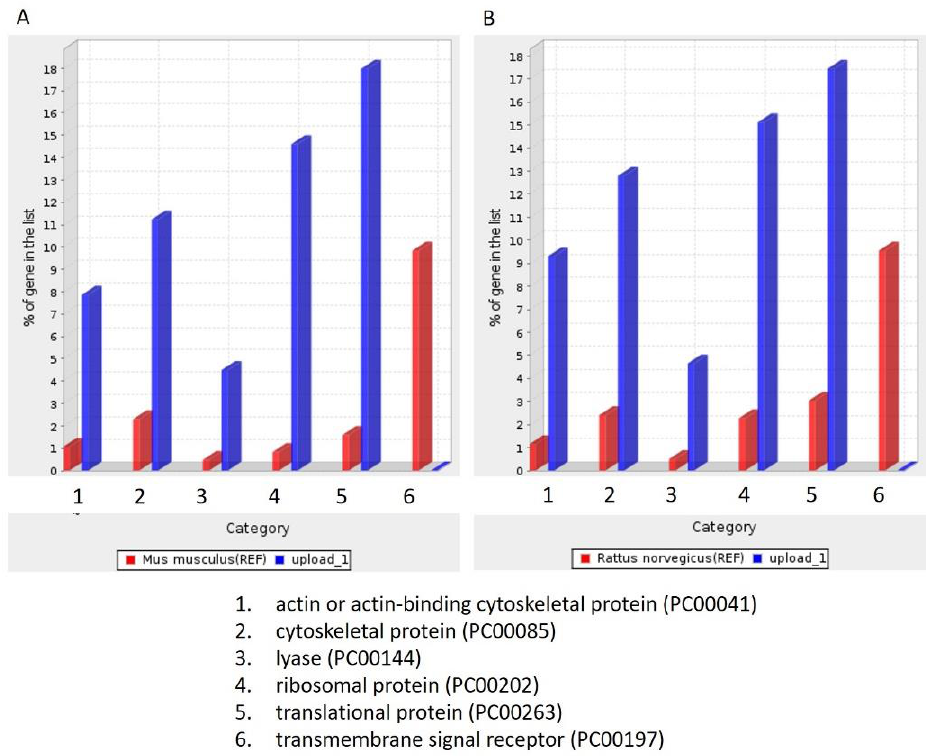
Figure 3. PANTHER protein class analysis. ( A ): Based on the Mus musculus database; ( B ): Based on Rattus norvegicus database.